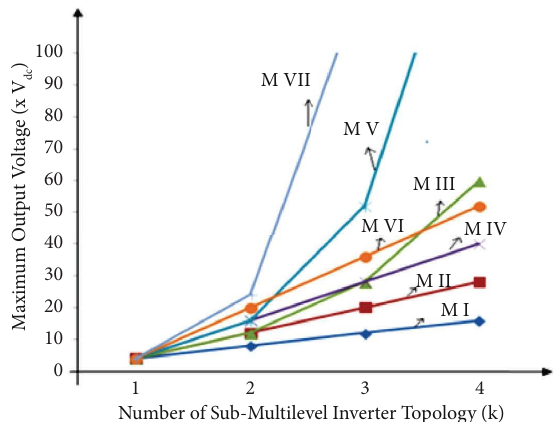
Figure 8: Variation of maximum output voltage with proposed submultilevel inverters.